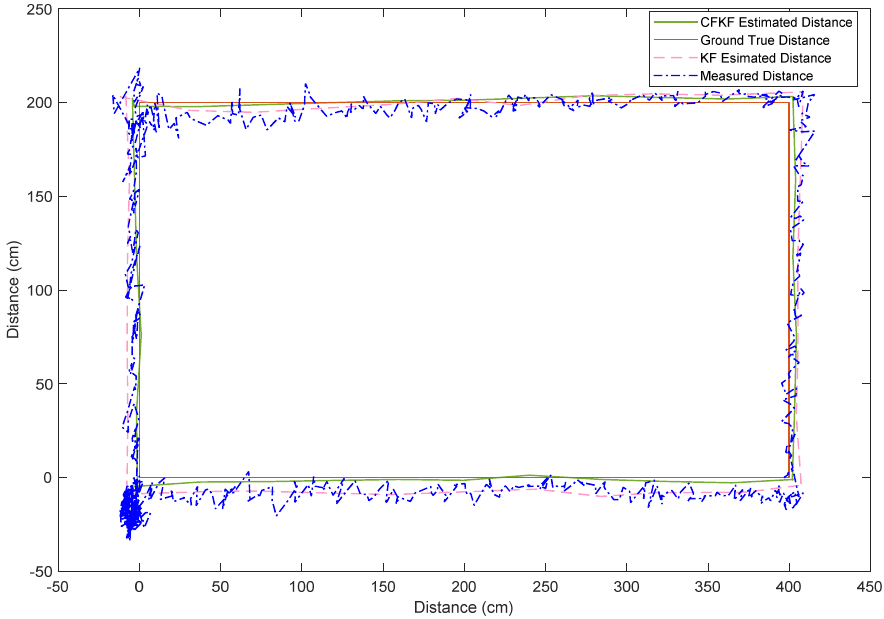
Figure 12. Comparison of different algorithm results in the UWB field experiment.